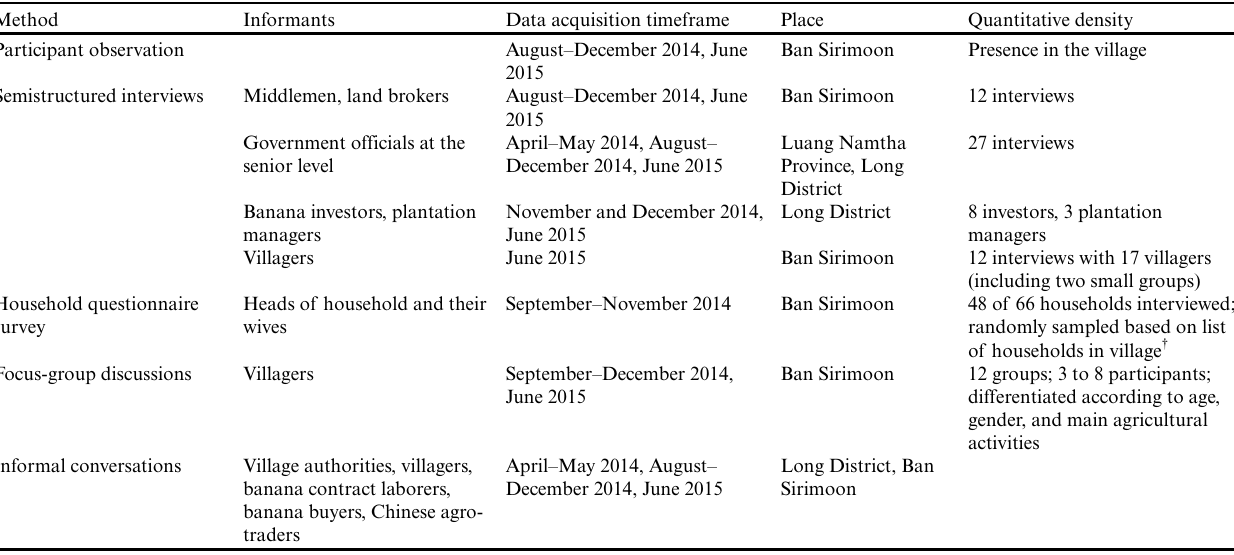
Table 1. Synthesis of methods used, informants, data acquisition timeframe, place, and quantitative